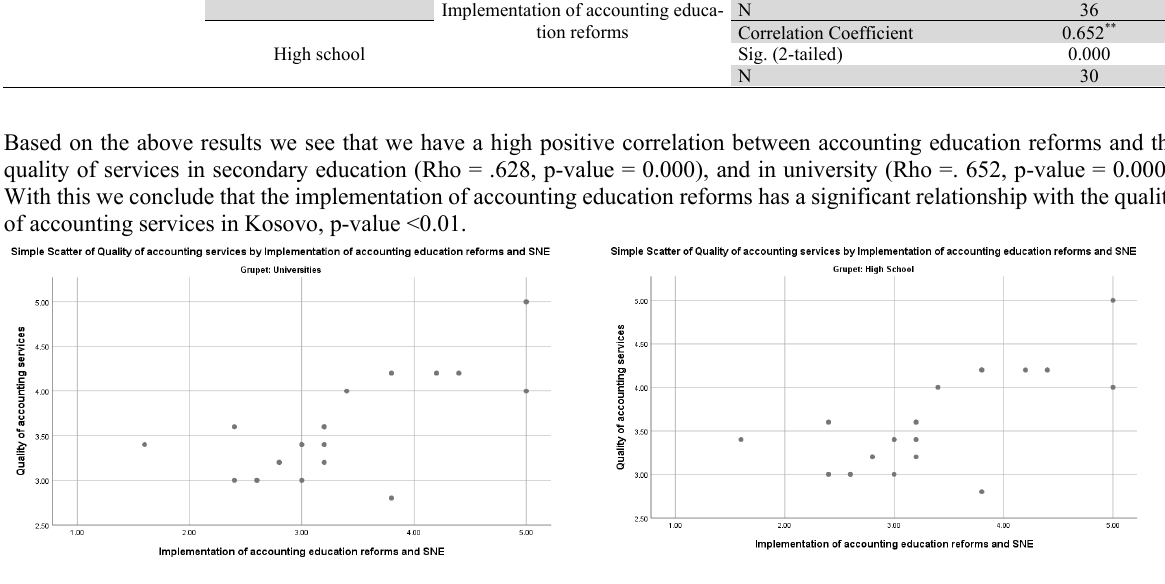
Fig. 5. The results of Simple Scatter of Quality of accounting services by implementation of accounting education reforms and